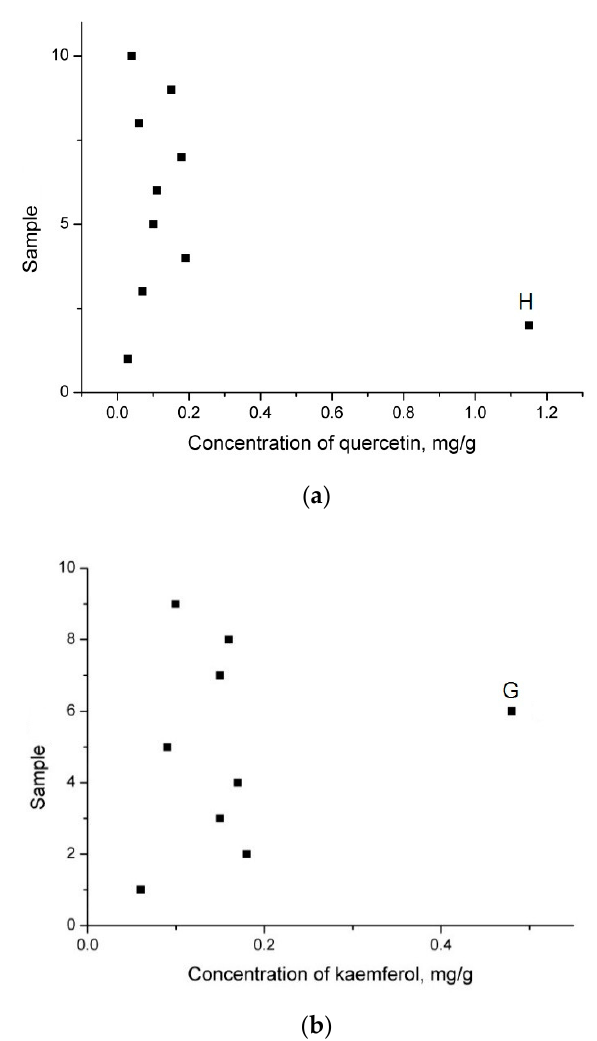
Figure 1. Distribution of the concentrations of quercetin ( a ) and kaempferol ( b ) in the samples Arnicae flos : H—origin Central America; G—origin Poland.